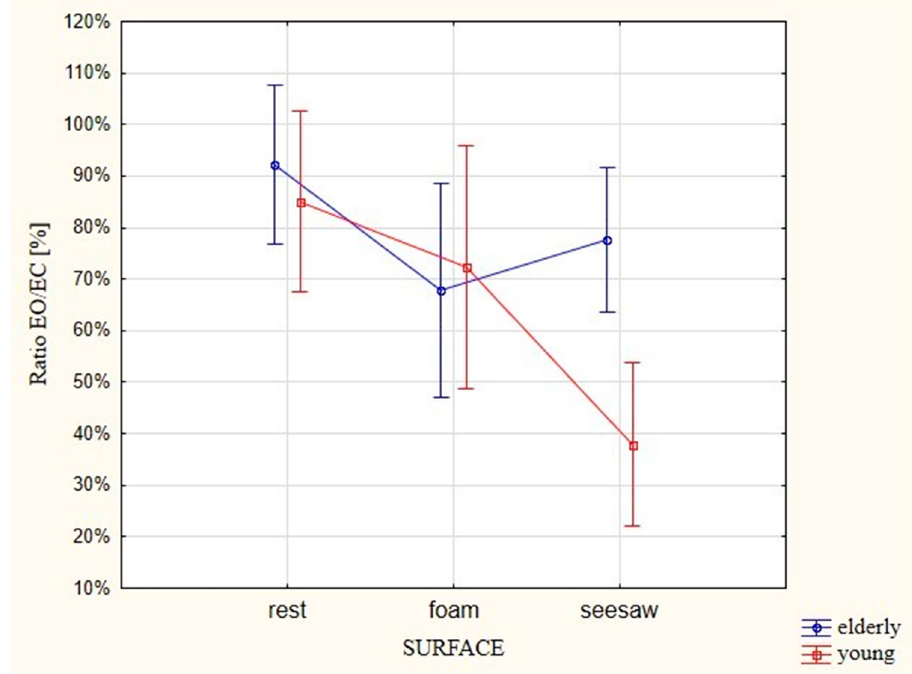
Figure 4. Comparison between groups of participants of different ages in terms of the EMG ratios (ratios of synergistic and antagonistic muscles of the ankle joint) for tests performed with EO versus EC on different types of surfaces.